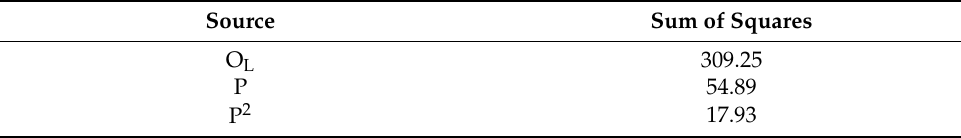
Table 10. Significant control factors for RSD